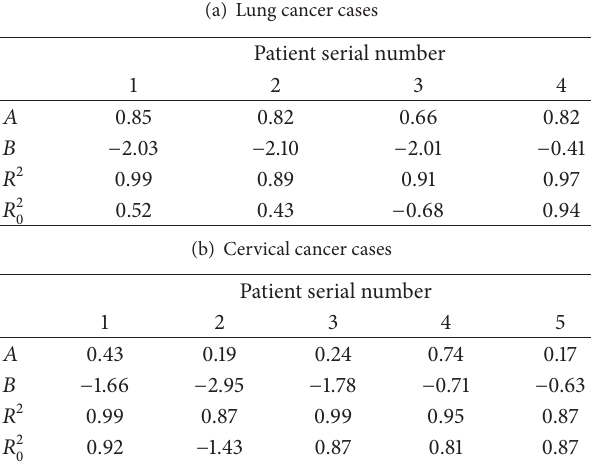
Table 2: Results of the model validation